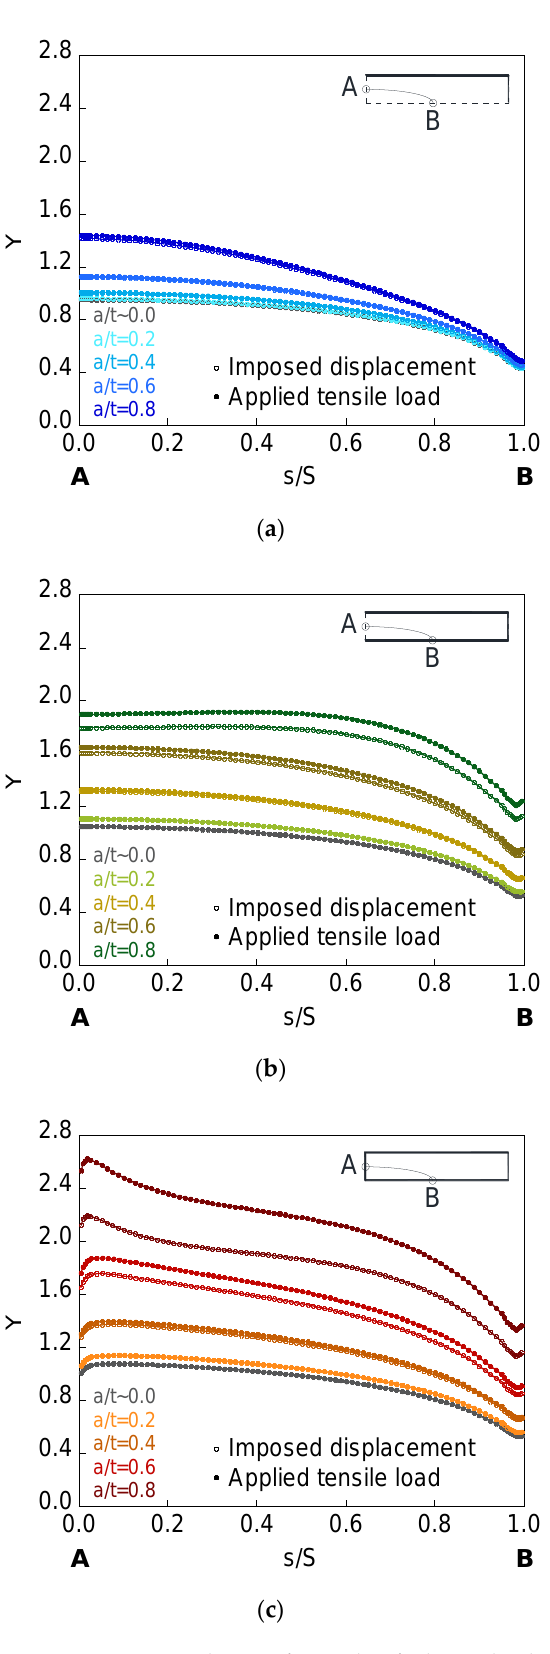
Figure 10. Dimensionless SIF for cracks of relative depths a / t = {~0.0, 0.2, 0.4, 0.6, 0.8} and aspect ratio a / b = 0.2 in a finite-thickness plate for the ( a ) embedded configuration, ( b ) superficial configuration, and ( c ) corner configuration.